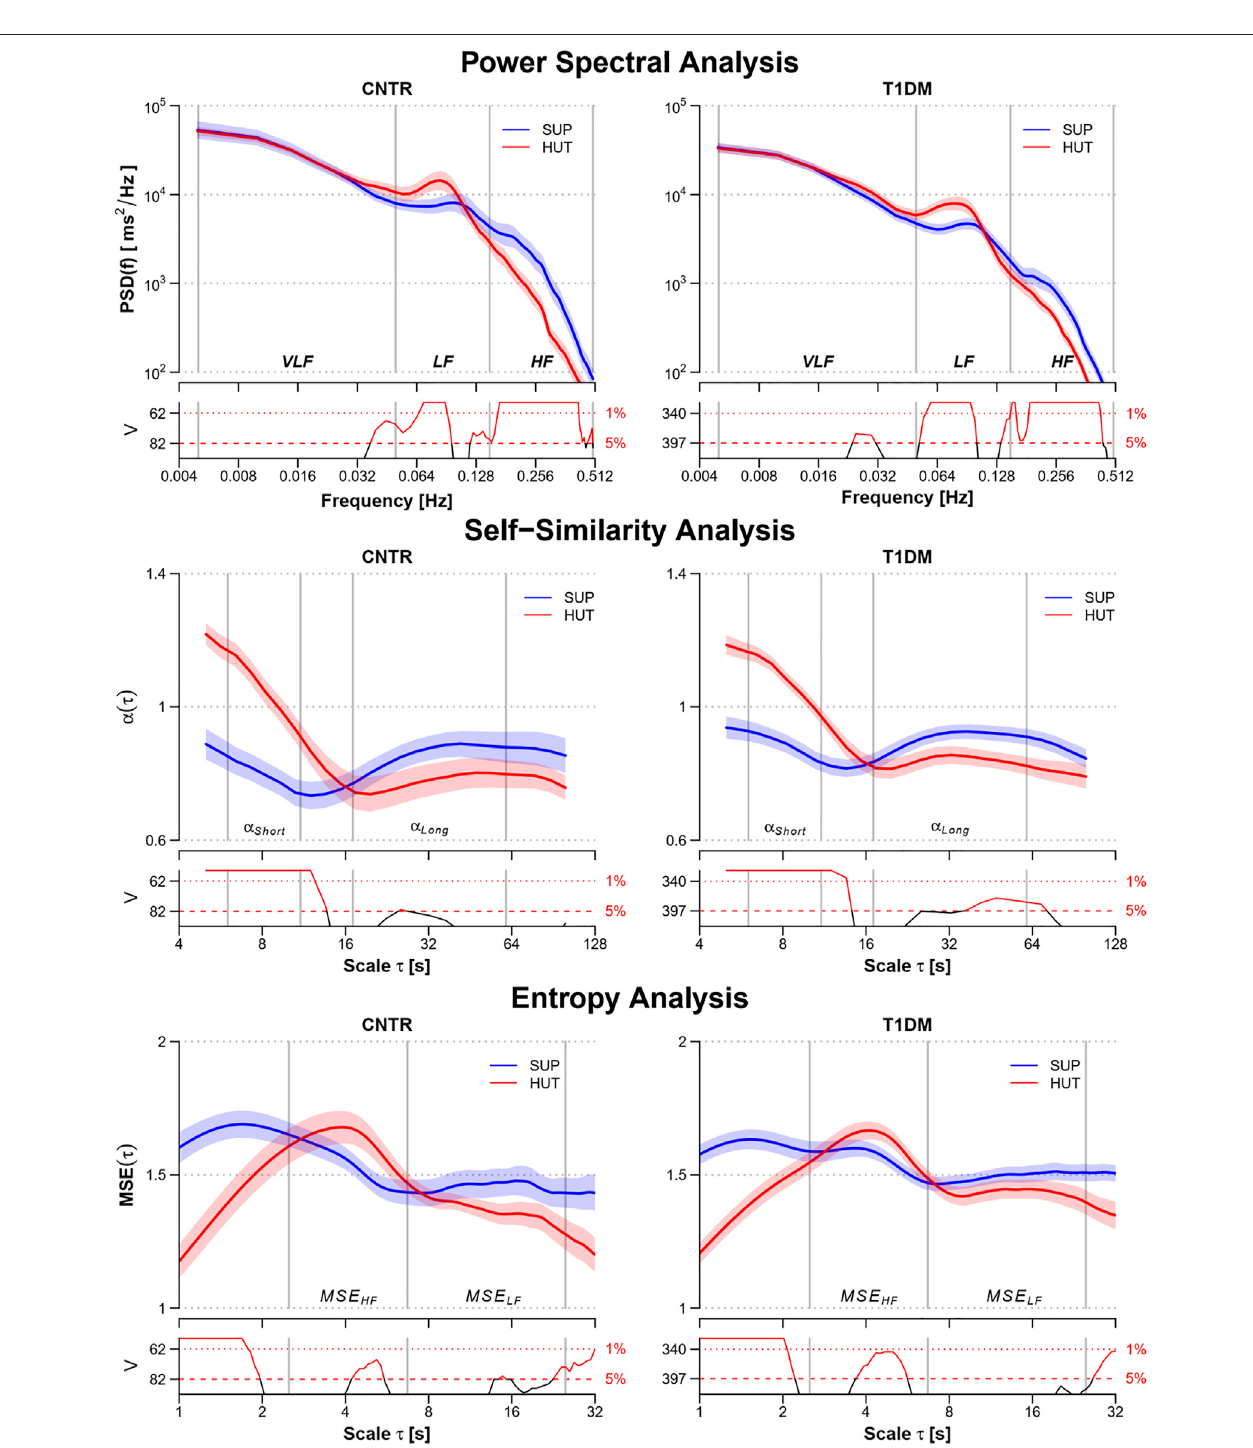
FIGURE 1 | Power spectra, PSD(f), multiscale self-similarity coef fi cients, α ( τ ), and multiscale entropy, MSE( τ ), in the control (CNTR) group and type-1 diabetic (T1DM) group during supine rest (SUP) and head-up tilt (HUT). From top to bottom: geometric mean ± geometric sem for PSD(f), mean ± sem for α ( τ ) and MSE( τ ). Grey vertical lines delimit the VLF, LF, and HF frequency bands of the power spectra; the short- and long-scale ranges of the self-similarity coef fi cients; and the HF and LF components of the multiscale entropy. The value of the V statistics of the Mann-Whitney test is reported below each panel: when the V value is above the dashed (dotted) horizontal lines,the difference betweenthe SUP and HUT posturesat the correspondingfrequencyorscale is statistically signi fi cantat the 5% (1%)signi fi cance level.